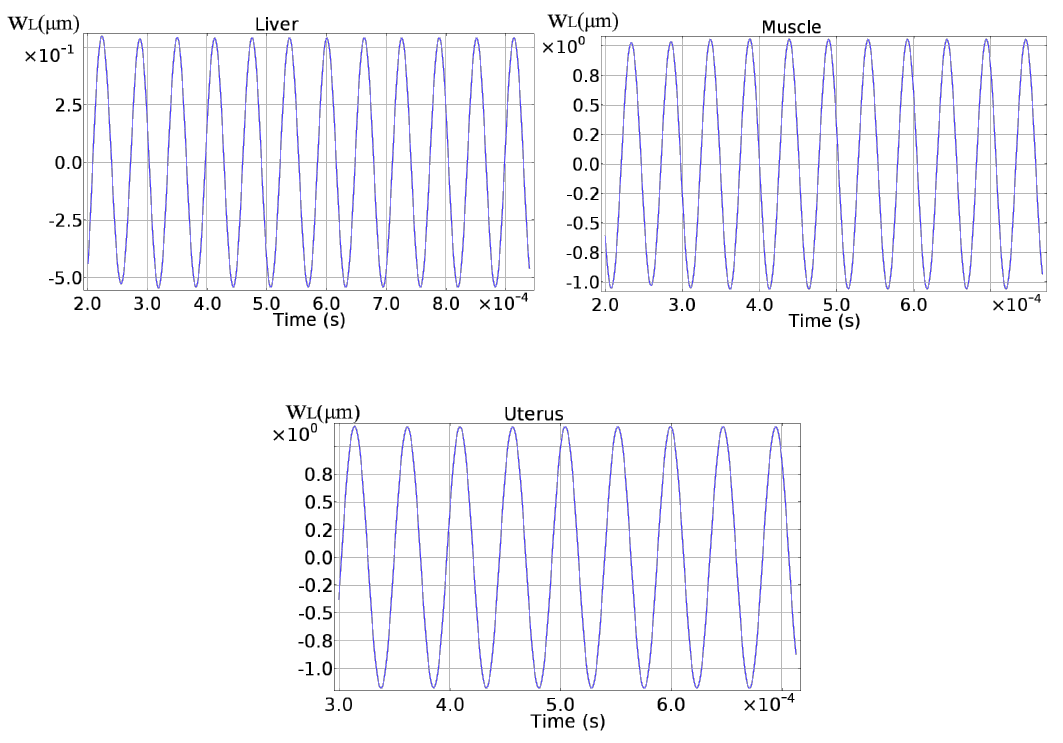
Figure 8. Axial displacement for the various soft tissues.